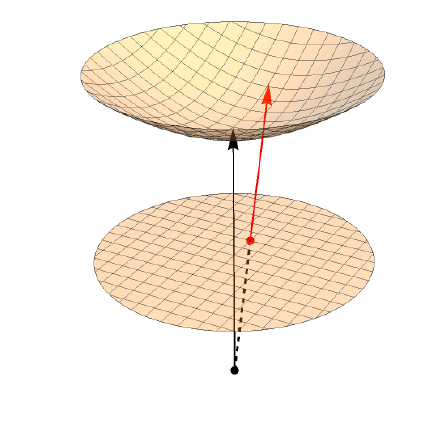
Figure 1. The Weierstrass map (cid:4) : D ! S + coincides with the projection of D from the point ( (cid:0) 1 ; 0 ; 0) of three-dimensional Minkowski space, when the Poincar(cid:19)e disk is placed in the plane X 0 = 0. Notice that the conformal boundary of D is mapped to the circle at in(cid:12)nity of S + . When u 2 D approaches the conformal boundary, the 3-vector (cid:4)( u ) (shown in red) becomes